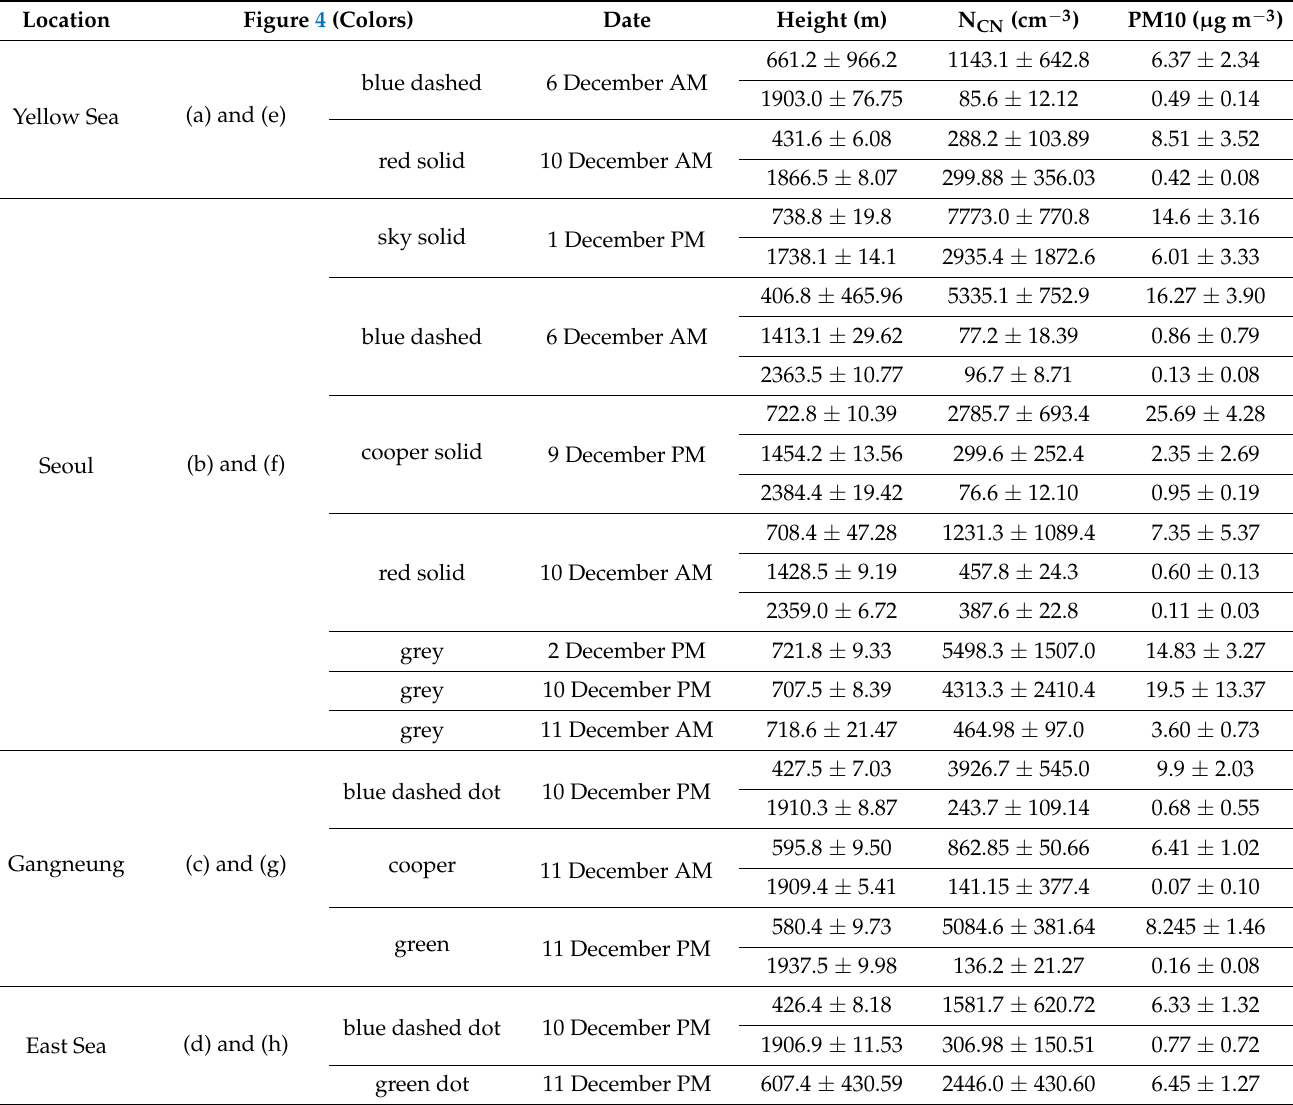
Table 2. The mean of N cn and PM10 for the level-leg flights shown in Figure